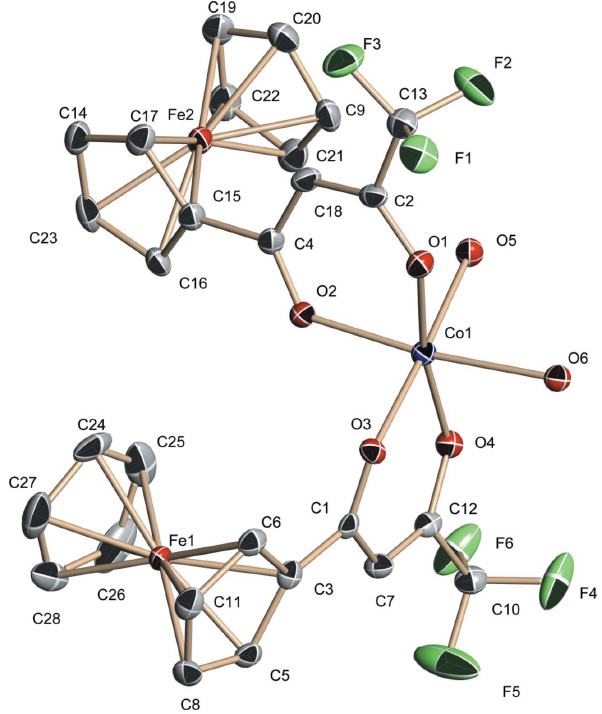
Figure 1 The molecular structure of the title compound with displacement ellipsoids drawn at the 30% probability level; H atoms are omitted for